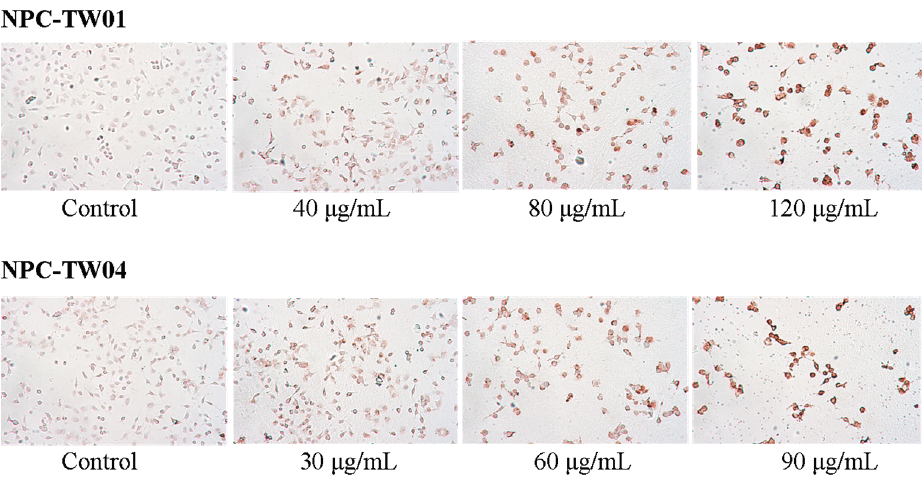
Figure 5. Apoptotic cells induced by PIRE in NPC cells. Detection of apoptotic cells by TUNEL assay. Cells were treated with varying concentrations of PRIE or control for 48